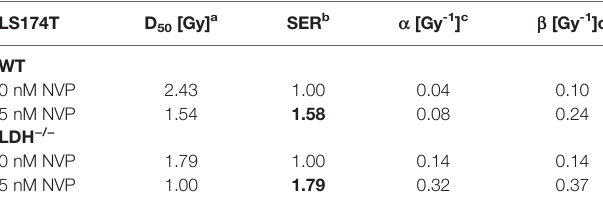
TABLE 1 | Summary of radiobiological parameters depicted in Figures 2A – D